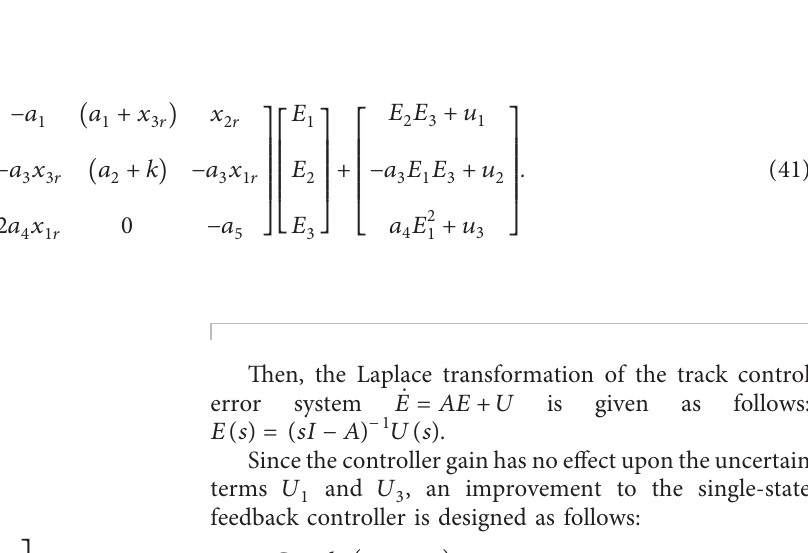
; (b) the state variable x 1